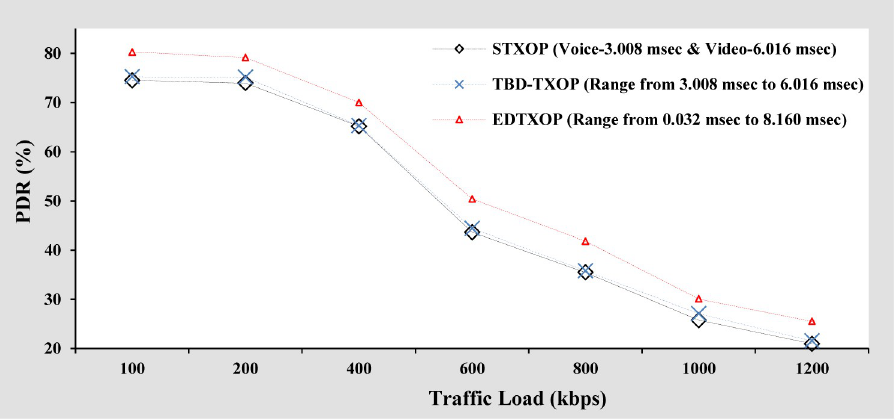
Fig 9. PDR analysis based on increasing packets arrival